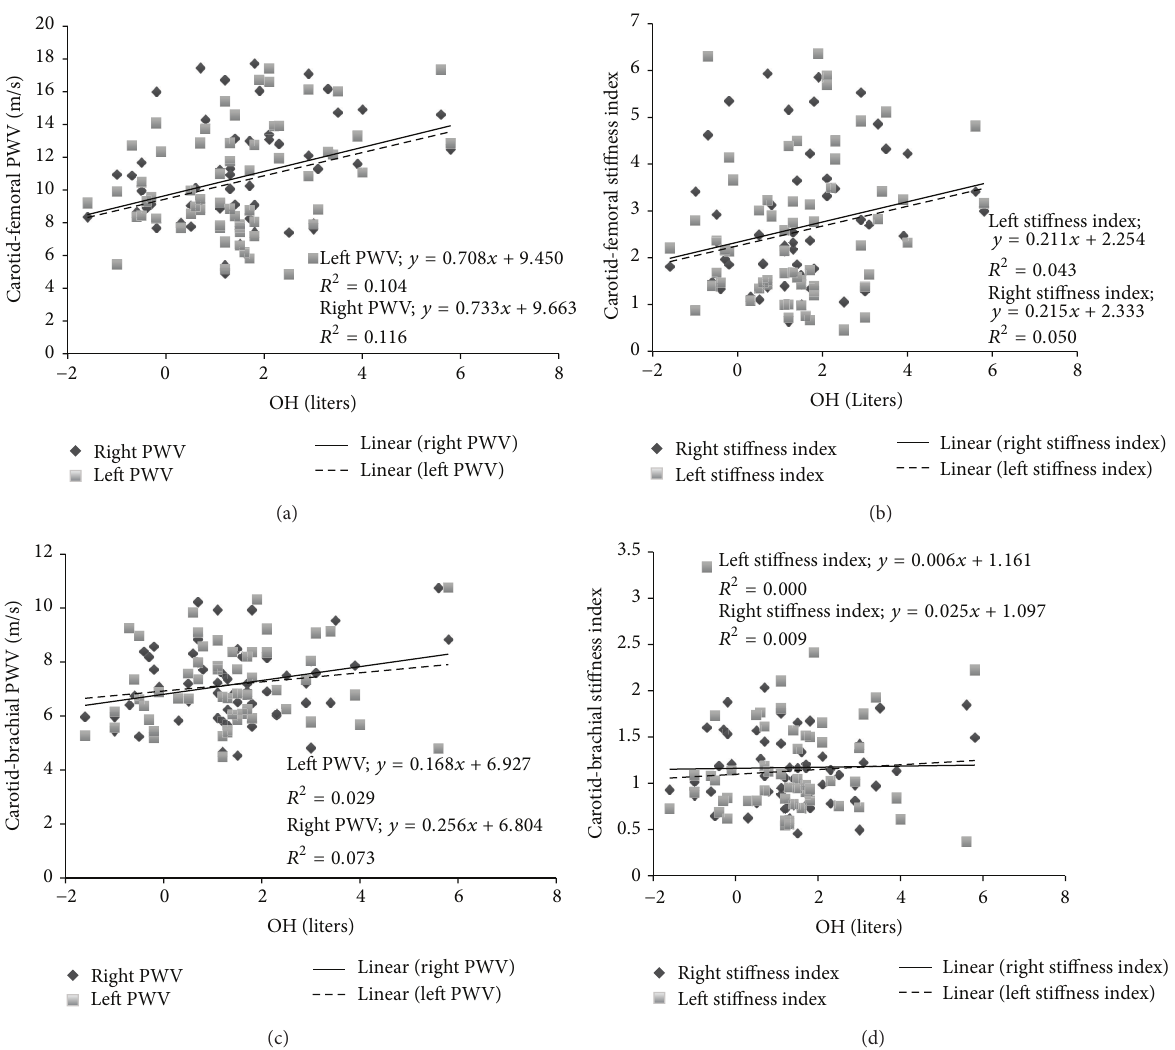
Figure 3: Pulse wave velocity (PWV) and hydration status evaluated through extracellular/overhydration ratio (OH) measured in absolute values using the multi-impedancimetric technique. The carotid-femoral PWV-OH relationship shows a significant relationship ( 𝑃 < 0.05 ), as does the stiffness index ( 𝛽 )-OH relationship ( 𝑃 < 0.05